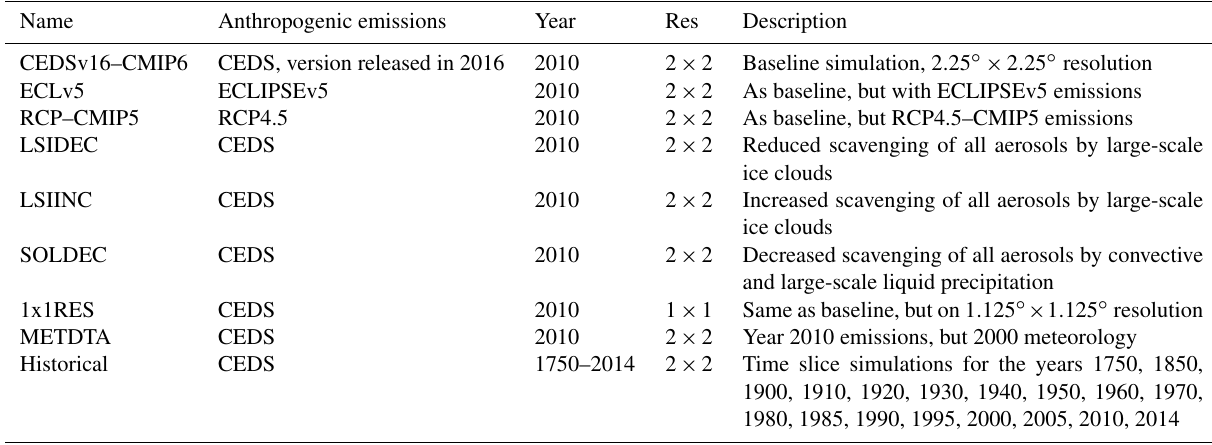
Table 1. Summary and description of simulations in this study.